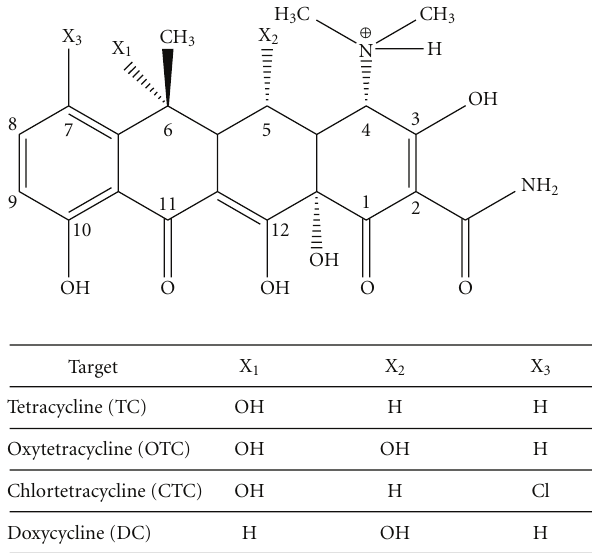
Figure 1: General structure of